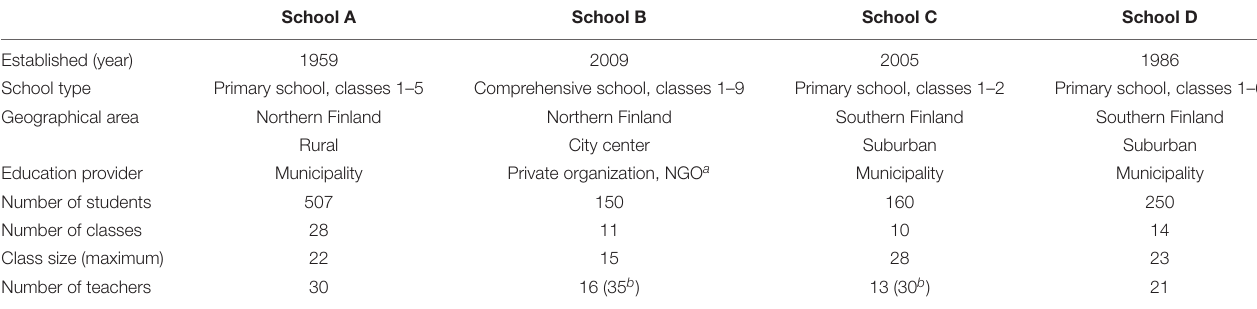
TABLE 2 | Background information of the schools.